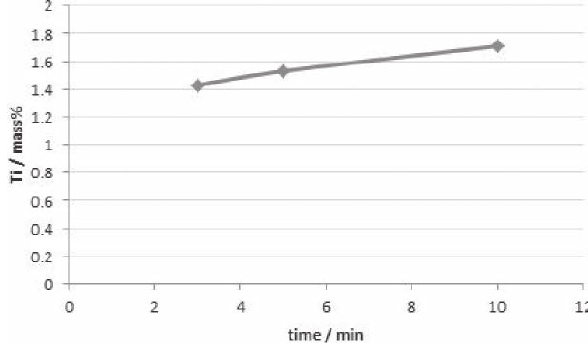
Fig. 9: Average Ti content in the alloy in the penetration zone vs. time in experiments